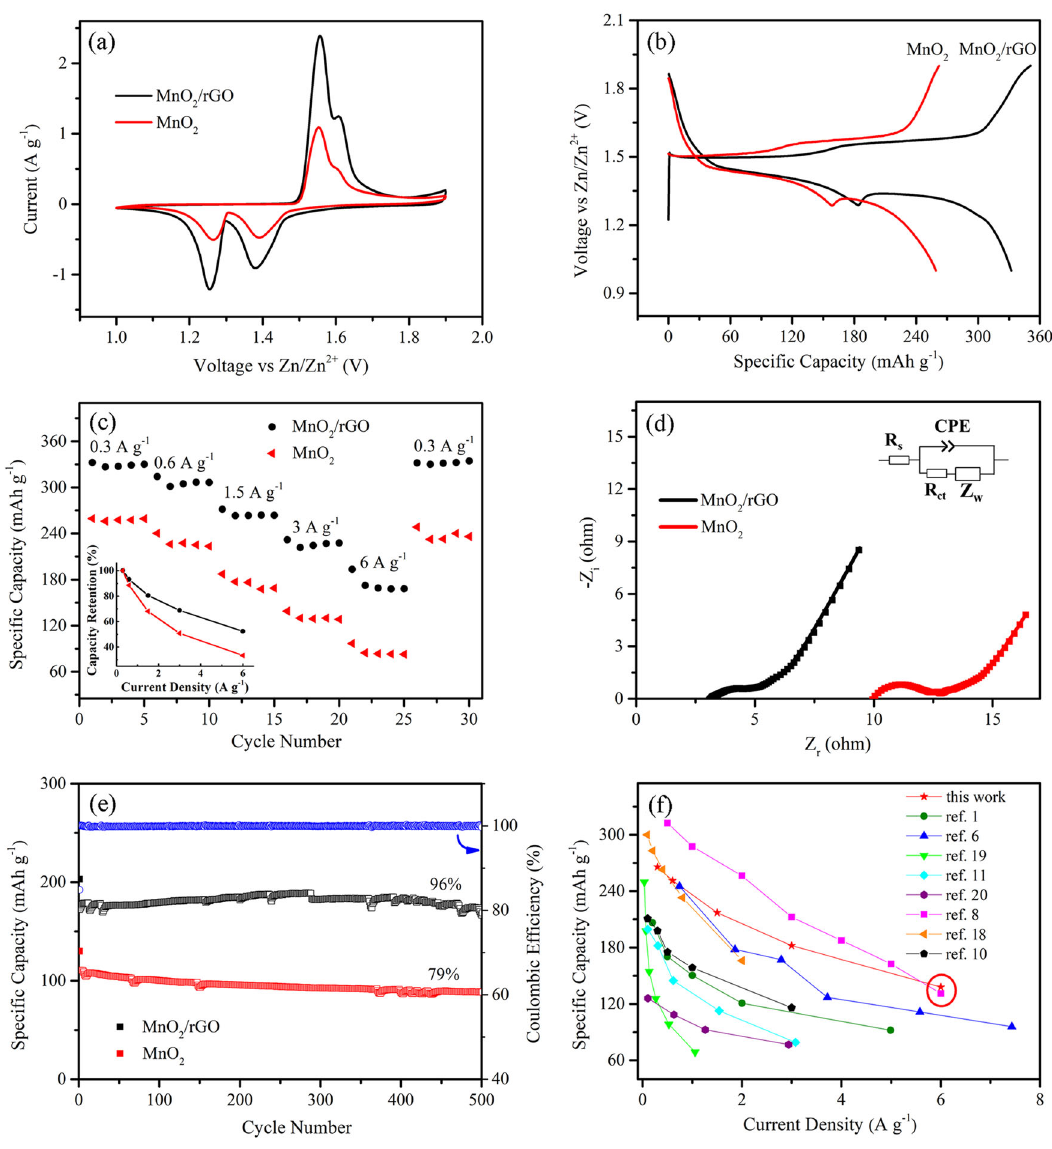
Fig. 3 Electrochemical performance of MnO 2 /rGO and conventional MnO 2 electrodes. a Cyclic voltammogram of the MnO 2 /rGO and conventional MnO 2 electrodes at a scan rate of 0.2 mV s -1 in 1.0 – 1.9 V vs. Zn 2 + /Zn. b Comparison of the charging and discharging pro fi les of the samples at the current density of 0.3 A g -1 . c Speci fi c capacities (normalized over the mass of MnO 2 ) of the samples at various current density. Inset in Fig. c : comparison of the speci fi c capacity retention of the samples. d Nyquist plots of the samples after charging to ~1.9 V vs. Zn 2 + /Zn. e Cycling stability of the samples (MnO 2 /rGO and conventional MnO 2 electrodes) cycled at 6.0 A g -1 and corresponding Coulombic ef fi ciency of MnO 2 /rGO electrode. f A summary graph of the speci fi c capacity (based on the total mass of the whole electrode material, including MnO 2 , additive and binder) of our MnO 2 /rGO electrode and other reported MnO 2 -based electrodes for ZIB at different current (e.g., R s : solution resistance; R ct : charge-transfer resistance; Z w : Warburg diffusion process) in this model can be calculated, as shown in Table S1 † . The charge-transfer resistance of MnO 2 /rGO sample is 1.2 Ω , which is lower than that of conventional MnO 2 number extended to 500 cycles at high current density of 6.0 A g -1 , sample (3.1 Ω ). The large R s difference of MnO 2 /rGO and conventional MnO 2 electrodes can be ascribed to the reduction indicating the excellent cycling stability of the MnO 2 /rGO sample. of internal resistance due to the rGO additive, which is conductive As a comparison, the capacity retention of the conventional MnO 2 sample at 6.0 A g -1 (after 500 cycles) is 79%. To examine the structure stability of the MnO 2 /rGO cathode and electroplated Zn anode, the morphological changes were characterized after the 300 cycles. For the cathode, as shown in Fig. S4c, MnO 2 /rGO structure after cycling remains nearly unchanged as compared to